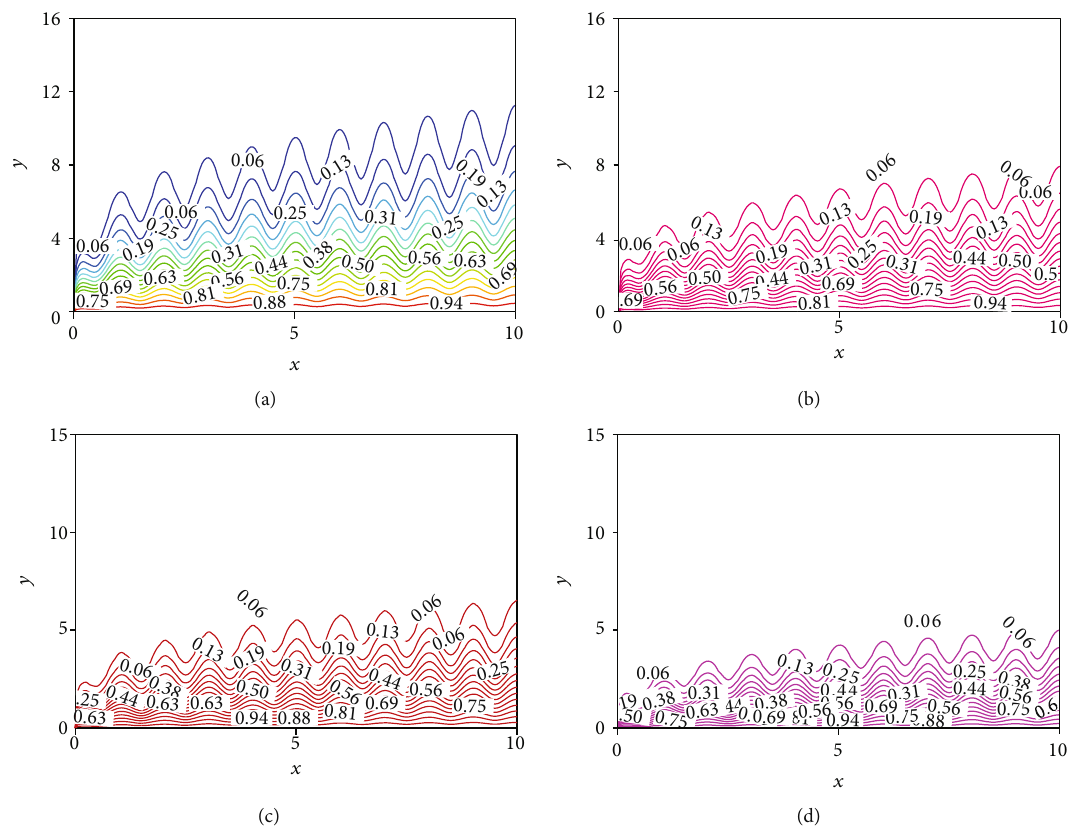
Figure 9: E ff ect of isotherms while γ = 0 : 05 and α = 0 : 3 , for (a) Pr = 0 : 73 , (b) Pr = 1 : 73 , (c) Pr = 3 : 0 , and (d) Pr = 7 : 0